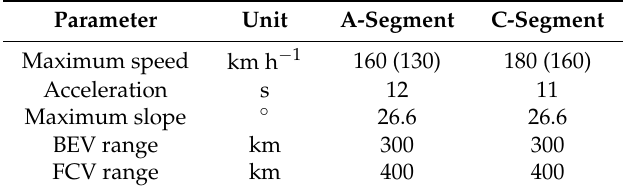
Table 5. Driving performance requirements for A- and C-segment passenger cars for the scaling of drives. β sl,max corresponds to a maximum slope of 50%; the values in brackets are applied to BEVs.